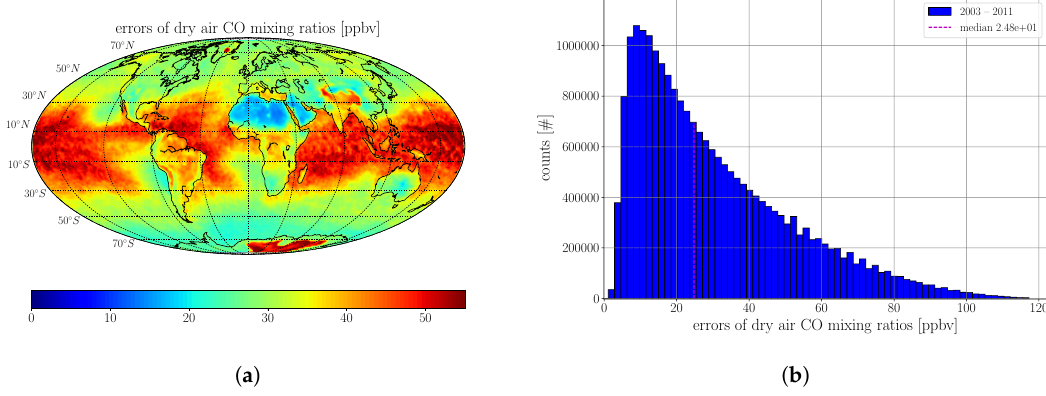
Figure 17. ( a ) Errors of the CO total columns for the observations presented in Figure 16. It clearly shows that errors are smallest in dry regions with low cloud coverage and high surface reflectivity (see the Sahara Desert, the Arabian Peninsula, Figure 1); ( b ) Frequency distribution of the errors including years from 2003–2011 (some individual years are shown in Figure